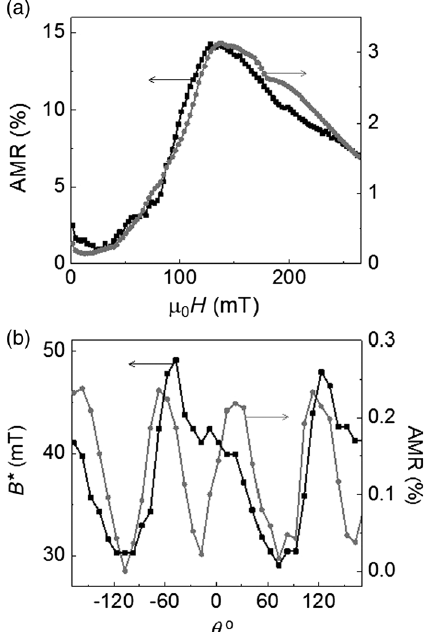
FIG. 2 (a) Variation of the AMR magnitude with the applied magnetic field for PC1 (gray) and PC2 (black). (b) Angular dependence of the “ coercive field ” H (cid:3) ( θ ) (black) for PC1. For comparison, the gray trace shows the low-field AMR data [top curve in Fig. 1(a)].